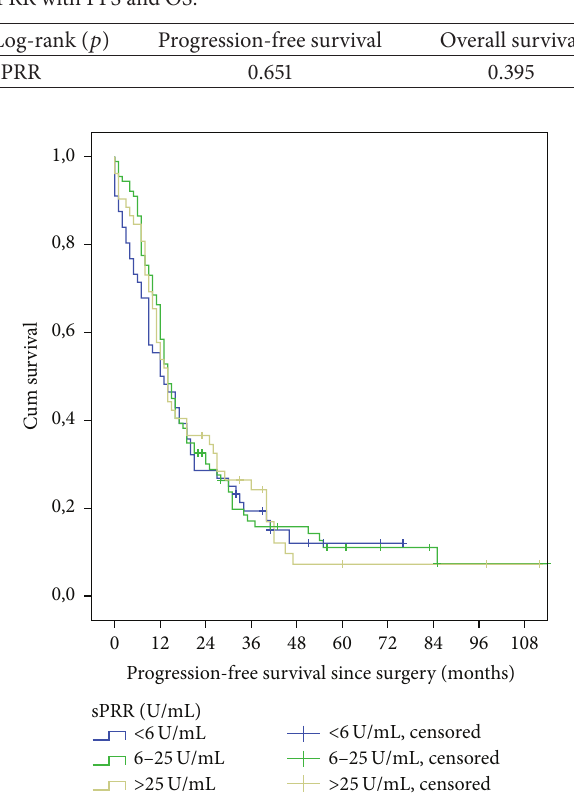
Figure2:Progression-freesurvivalcurvesforsPRR-levelsubgroups ( 𝑝 = 0.651 ).